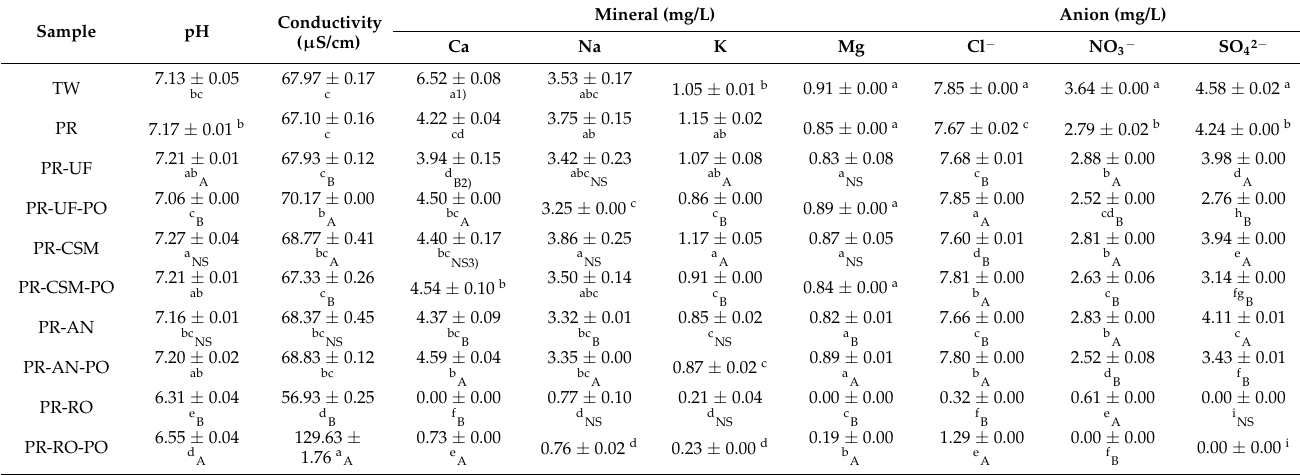
(1) Different superscripts within a row mean significant differences across the samples by Tukey’s test at p < 0.05. (2) Different subscripts within each sample group mean significant differences between samples at p < 0.05. (3) NS means not significant between the samples within each group at p <